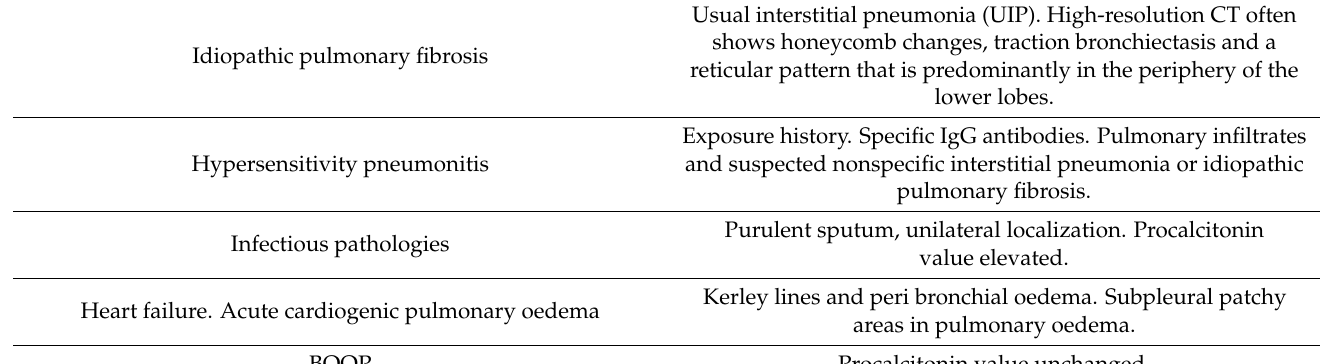
Table 1. Main differential diagnostics of amiodarone-induced pulmonary